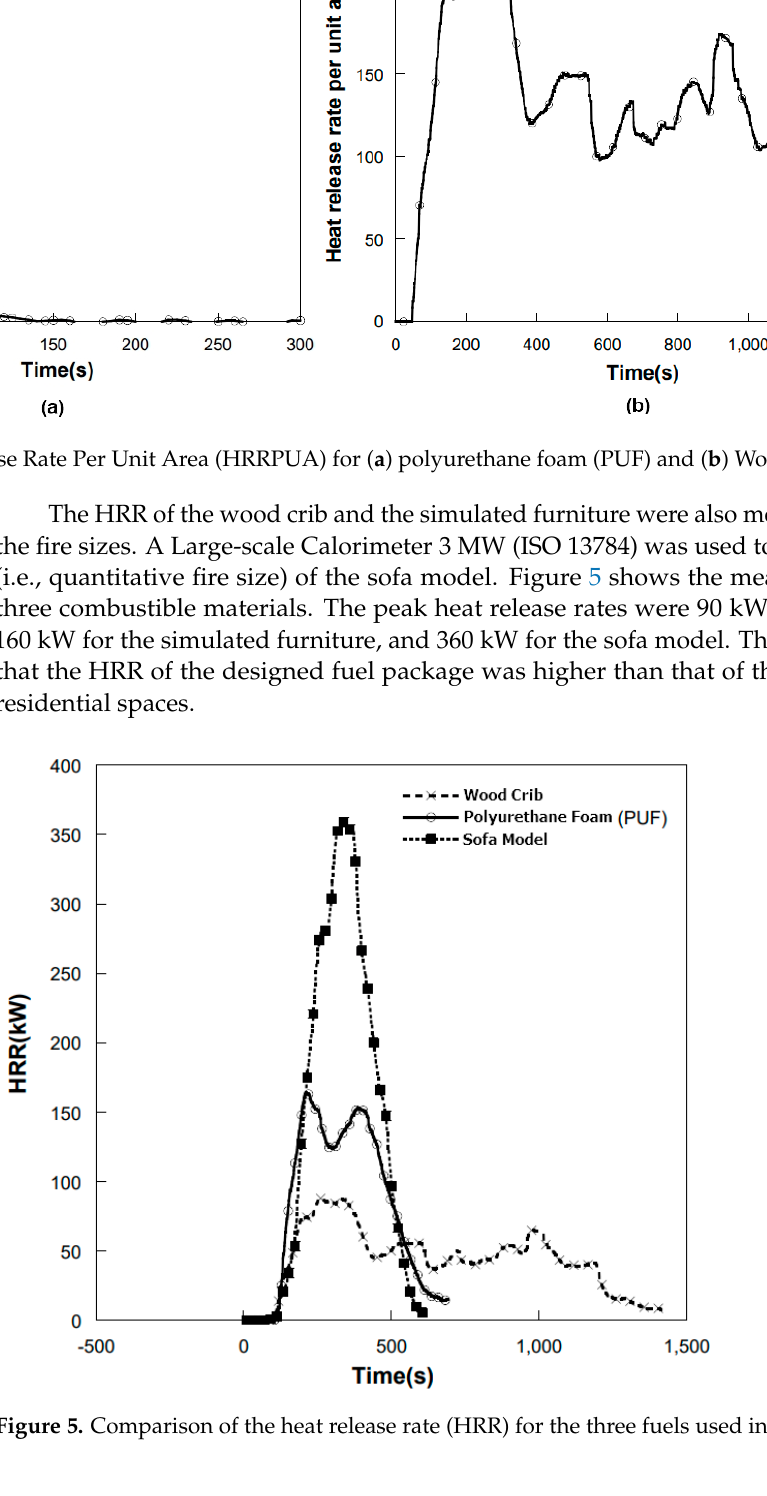
Figure 5. Comparison of the heat release rate (HRR) for the three fuels used in fire testing.